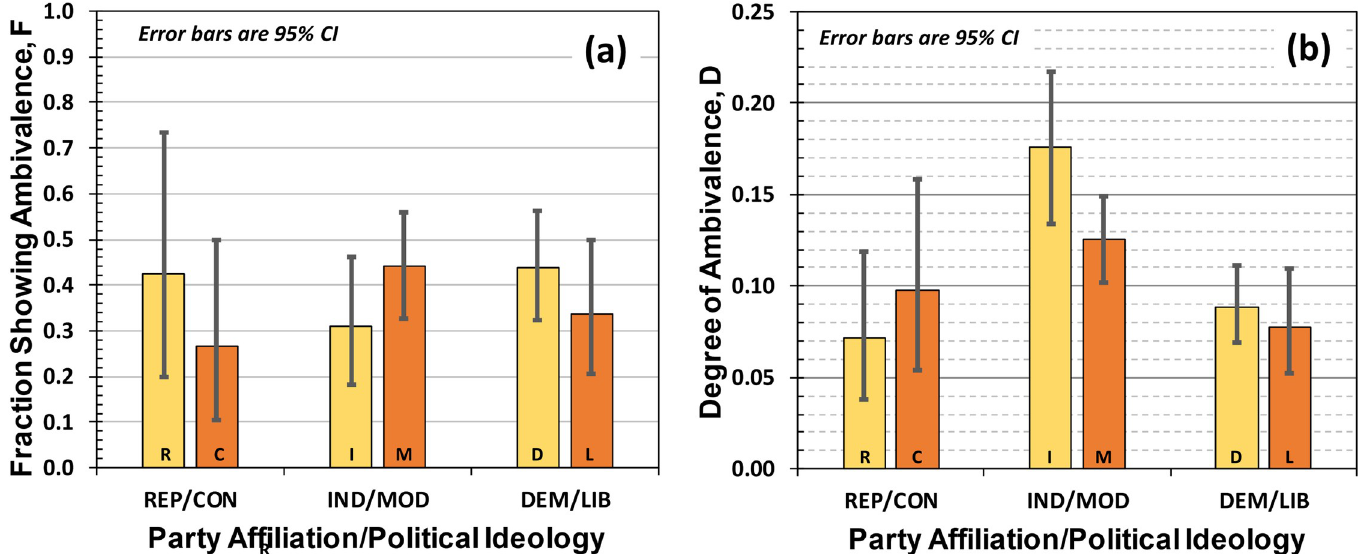
Fig 6. (a) Fraction of the population showing ambivalence, F, which in all cases looks to be around 30% to 40%. (b) Degree of ambivalence, D, which is the probability that an ambivalent participant will double-respond to a questionnaire item.